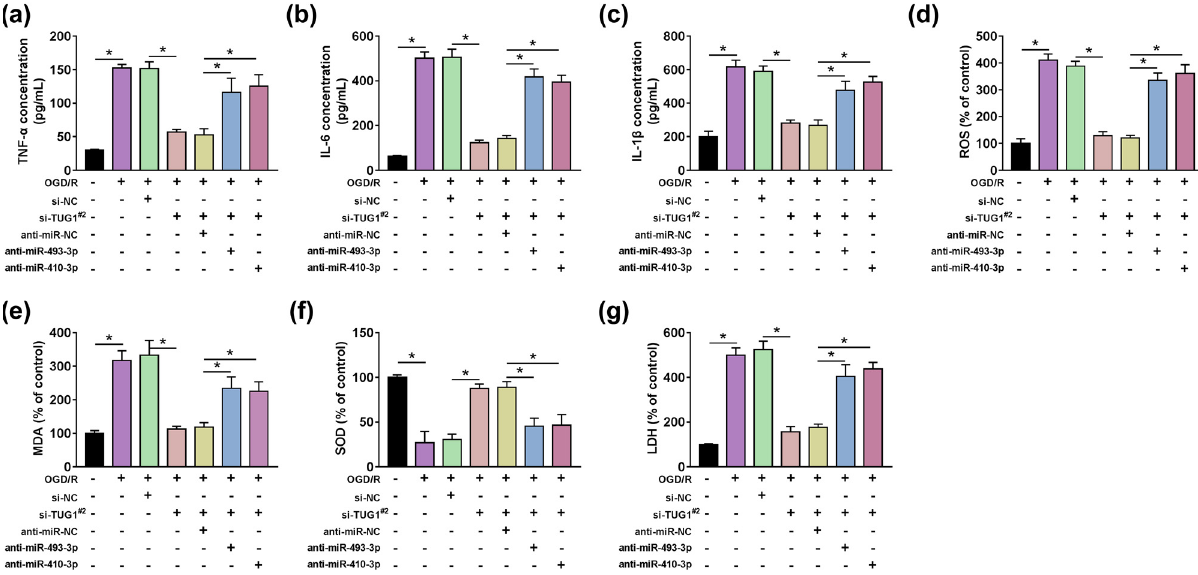
Figure 6: The inhibition of miR - 493 - 3p or miR - 410 - 3p could restore the reverse e ff ects of TUG1 knockdown on OGD/R - mediated decrease in in fl ammation and oxidative stress in N2a cells in vitro . ( a – c ) The concentration of TNF - α , IL - 6 and IL - 1 β was measured by ELISA in N2a cells, which transfected with si - TUG1 #2 + anti - miR - 493 - 3p or si - TUG1 #2 + anti - miR - 410 - 3p or negative controls, with or without being treated by OGD/R. ( d ) The e ff ect of si - TUG1 #2 and anti - miR - 493 - 3p or anti - miR - 410 - 3p on ROS generation was analyzed by Reactive oxygen species assay kit in N2a cells with or without being treated by OGD/R. ( e – g ) The intracellular levels of MDA, SOD and LDH were measured by colorimetry in N2a cells, which transfected with si - TUG1 #2 + anti - miR - 493 - 3p or si - TUG1 #2 + anti - miR - 410 - 3p or negative controls, with or without being treated by OGD/R. * P < 0.05.